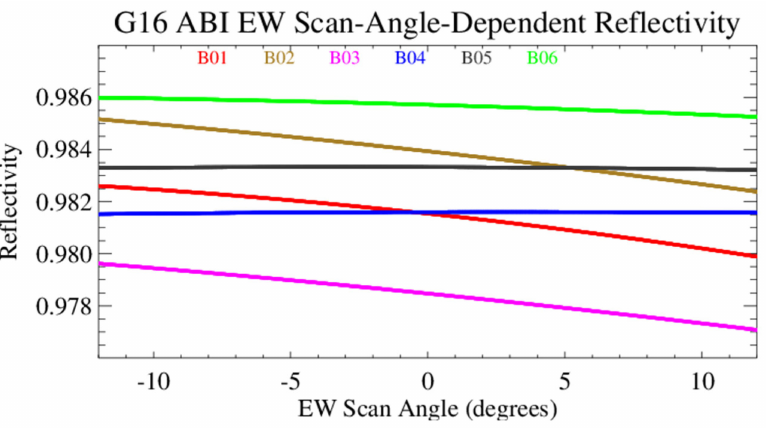
Figure 7. The EW scan-angle-dependent ABI scan-mirror reflectivity for the six G16 VNIR bands.